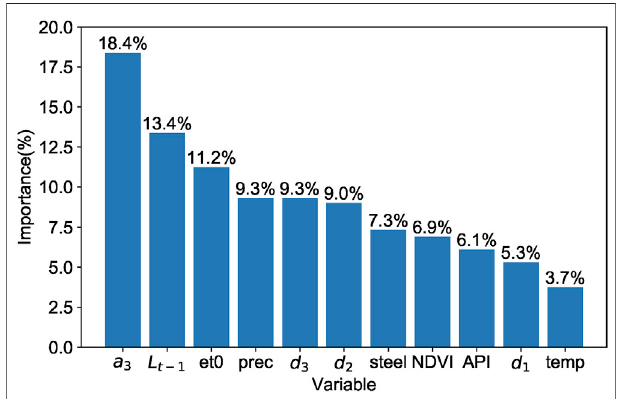
Frontiers in Environmental Science |